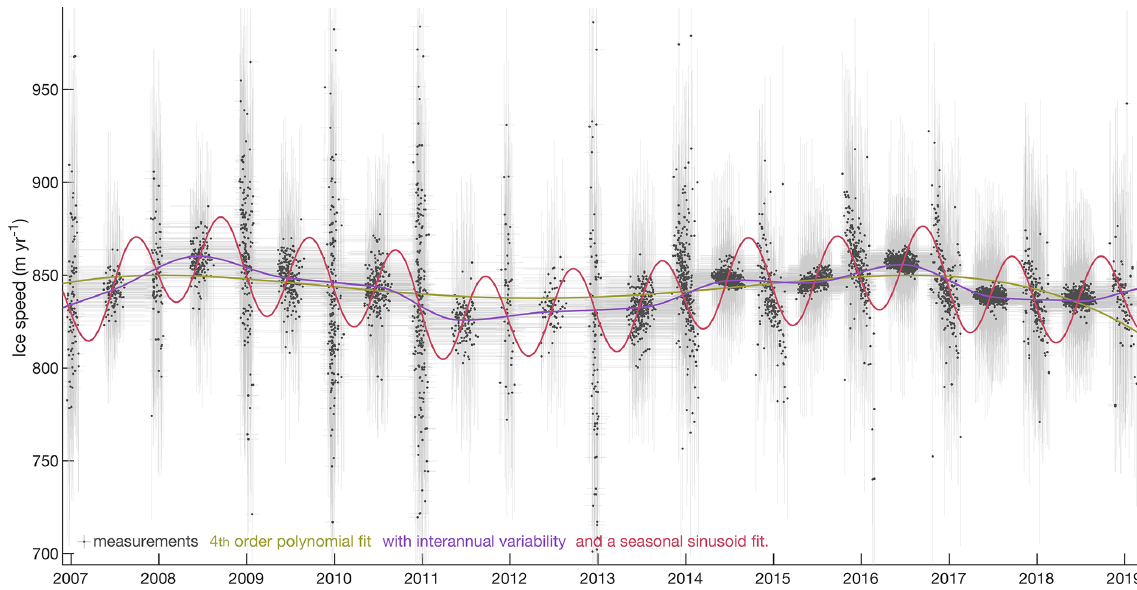
Figure 4. Velocity time series for an ITS_LIVE pixel. The clustering of these 14208 measurements taken near the grounding line of Byrd Glacier typifies ITS_LIVE image pair data, with short- (cid:49)t measurements providing direct but noisy observations of velocity variability throughout each summer, while much lower-noise winter estimates can only give insight into the total displacement that occurs during the dark, winter months. Light-gray horizontal bars connect the acquisition times of each image pair, and vertical bars show ± 1 σ v uncertainty. Center dates t m are shown as dark-gray dots for visual